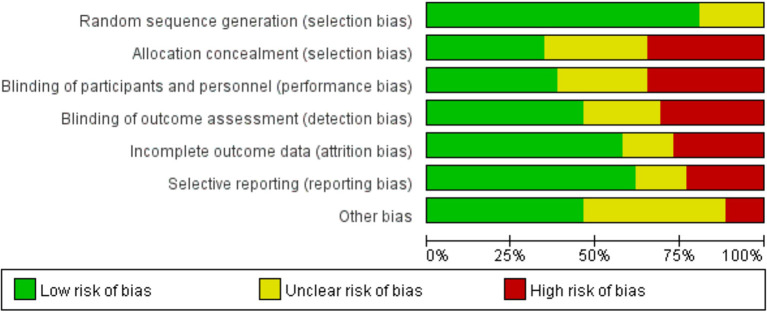
Risk of bias graph showing the review authors’ judgments about each risk-of-bias item presented as percentages across all included studies.